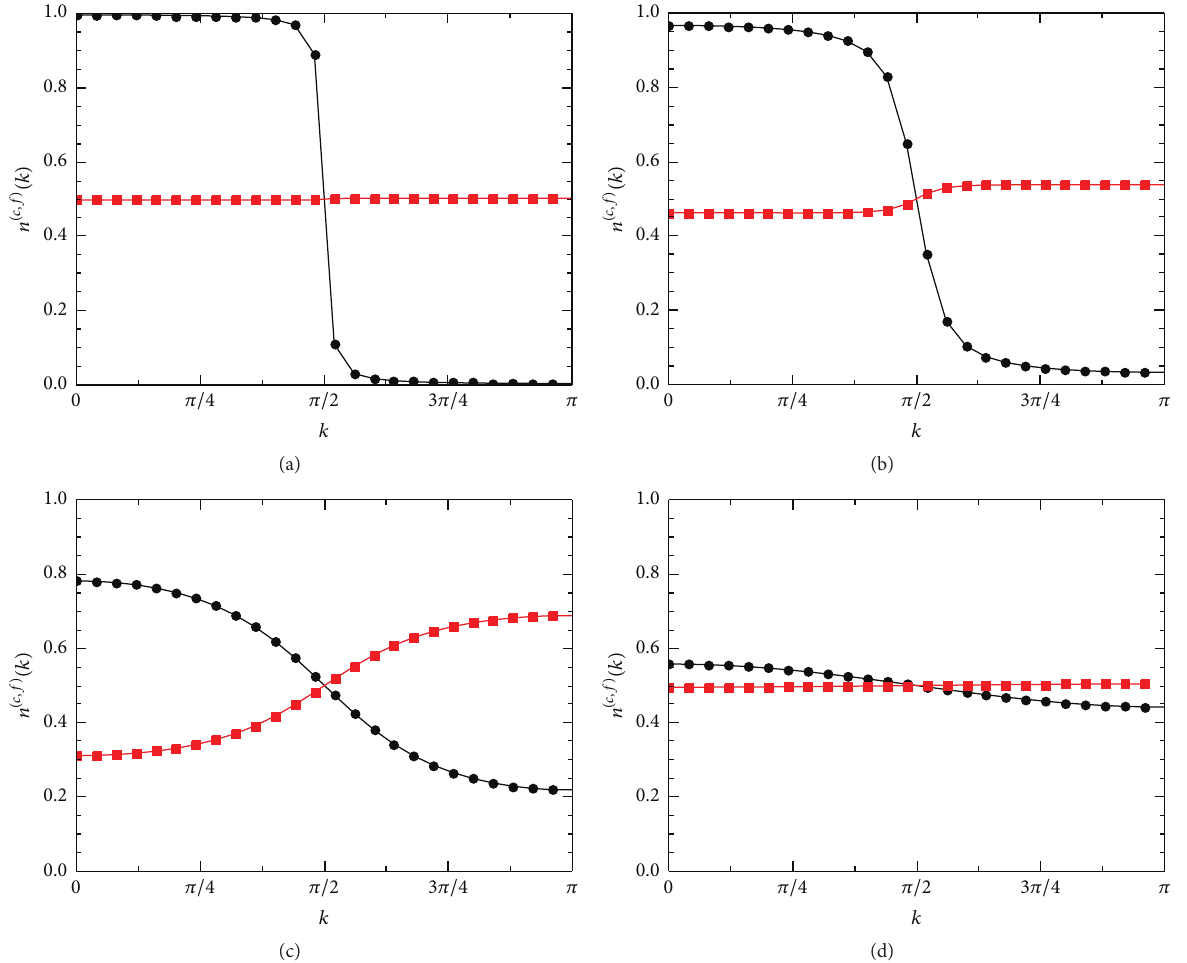
Figure 2: Momentum distribution functions of the conduction (bullet) and 𝑓 (red square) electrons for 𝐿 = 50 and 𝑛 = 2 . Panels (a), (b), (c), and (d) correspond to 𝑈 𝑐𝑓 /𝑊 = 0, 1.5, 1.7 , and 3; furthermore 𝑈 𝑓 /𝑊 = 3 , 𝑉/𝑊 = 0.1 , and 𝜀 𝑓 = −𝑈 𝑓 /2 in all cases. The lines are guides to the